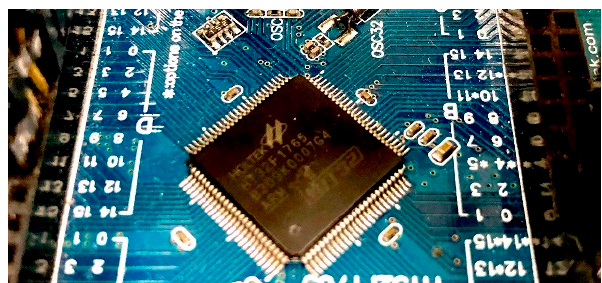
Figure 6. Holtek 32-bit microcontroller.